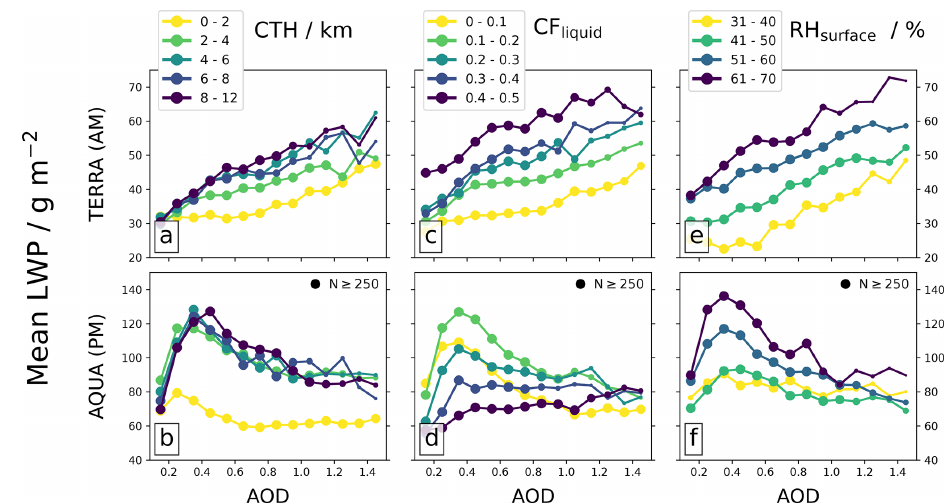
Figure 4. Geometric mean LWP as a function of AOD, subset by different cloud or environmental properties: MODIS cloud top height (a–b) , MODIS liquid cloud fraction (c–d) , and AIRS surface-level RH (e–f) . For each plot, the top panel is for the TERRA overpass, and bottom panel is for the AQUA overpass. The size of each circle gives a representation of how many scenes are included in the mean, with a maximum size shown for N ≥ 250.